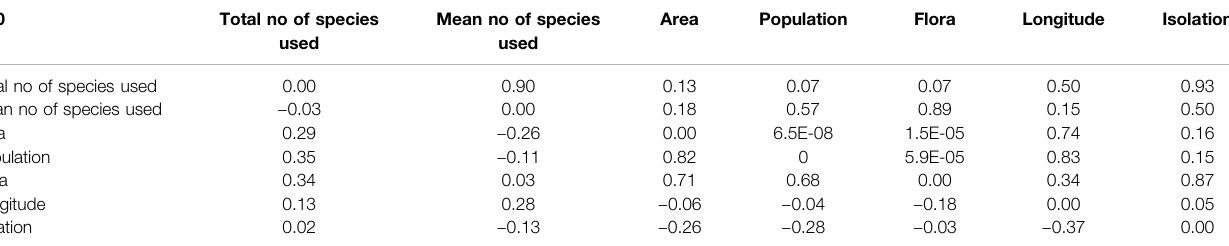
TABLE 5 | Correlation matrix of the variables studied (data for 29 islands, those for which the number of species in their fl ora is known). Left-bottom corner – correlation coef fi cient r, Right-top corner p values. Correlation matrix for the studied variables.